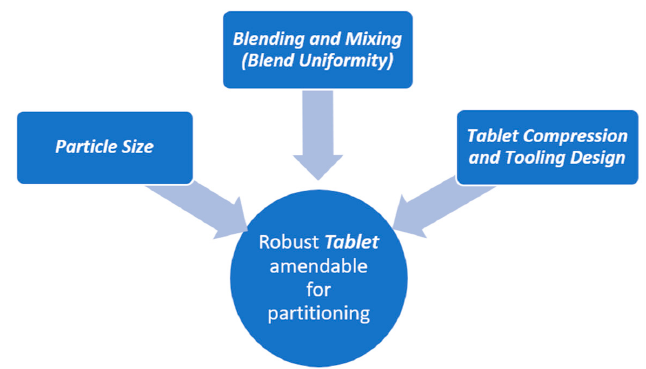
Figure 6. Factors to consider for tablet formulations in order to facilitate proper splitting.